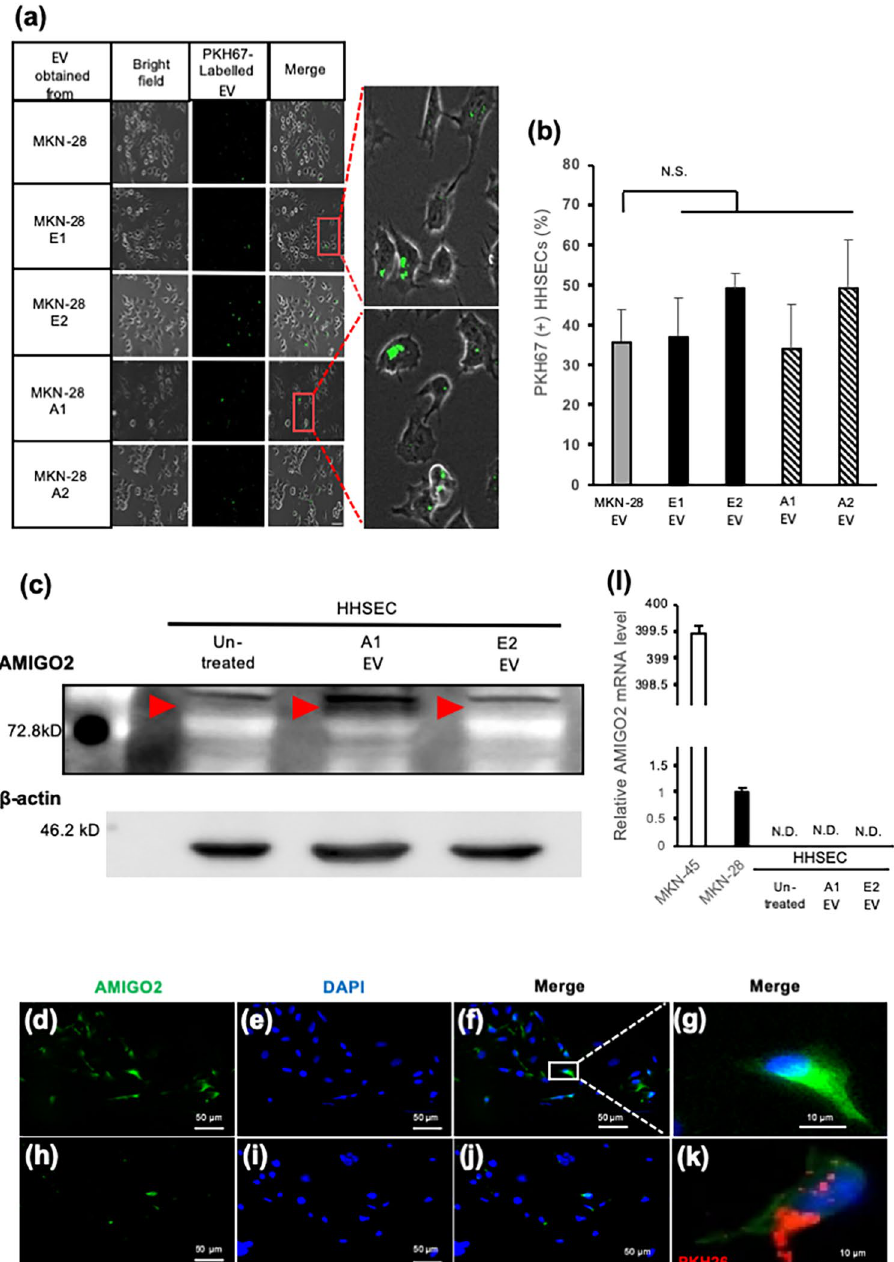
Figure 2. AMIGO2 was delivered to human hepatic sinusoidal endothelial cells. ( a ) EVs (green) were observed to incorporate into HHSECs within 6 h by microscopy (Keyence, Japan). Scale bar, 50 µm. ( b ) EVs from each cell line were almost evenly incorporated into HHSECs. Bar graphs show mean ± SD (n = 5 in each group). N.S., no significance based on the Dunnett’s test. ( c ) The expression of AMIGO2 in HHSECs treated with AMIGO2- containing EVs was increased by western blotting. Full-length blots were presented in Supplementary Fig. S4. ( d – k ) AMIGO2 (green) in HHSECs was detected by immunocytochemistry. HHSECs were treated with A1